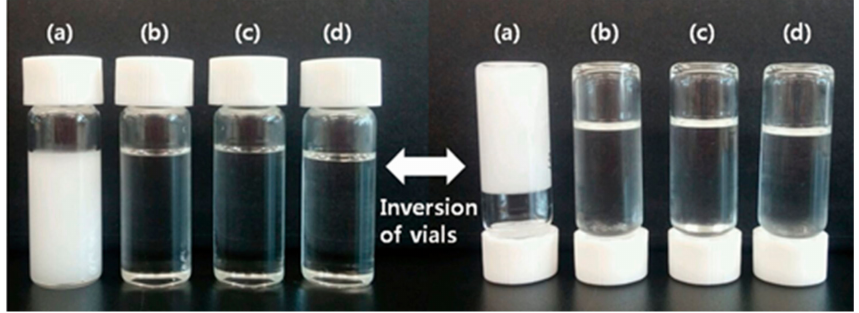
Figure 1. Photographs of the carbonate-type macrodiols of ( a ) M1-1K , ( b ) M2-1K , ( c ) M3-1K and ( d ) M3-1.5K at 20 ◦ C.